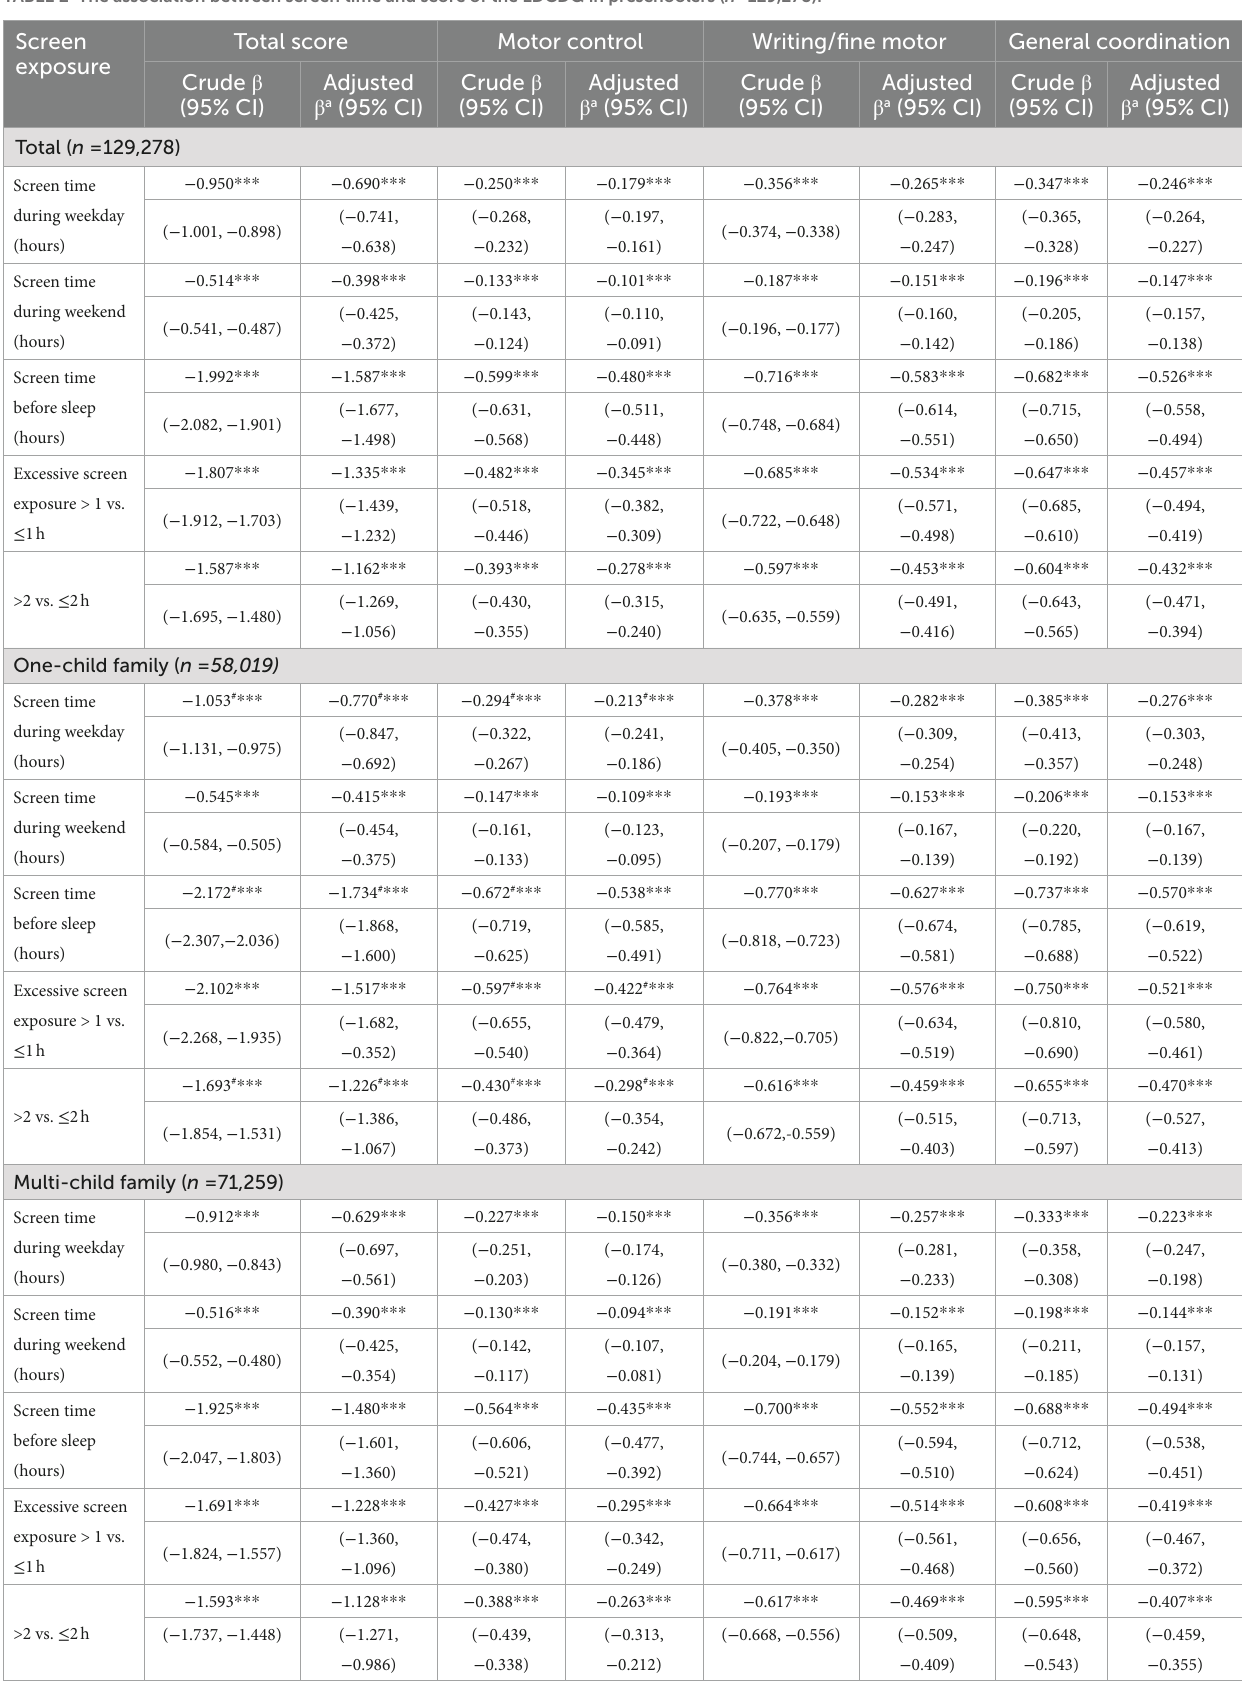
TABLE 2 The association between screen time and score of the LDCDQ in preschoolers ( n = 129,278). Screen Total score Motor control Writing/fine motor General exposure